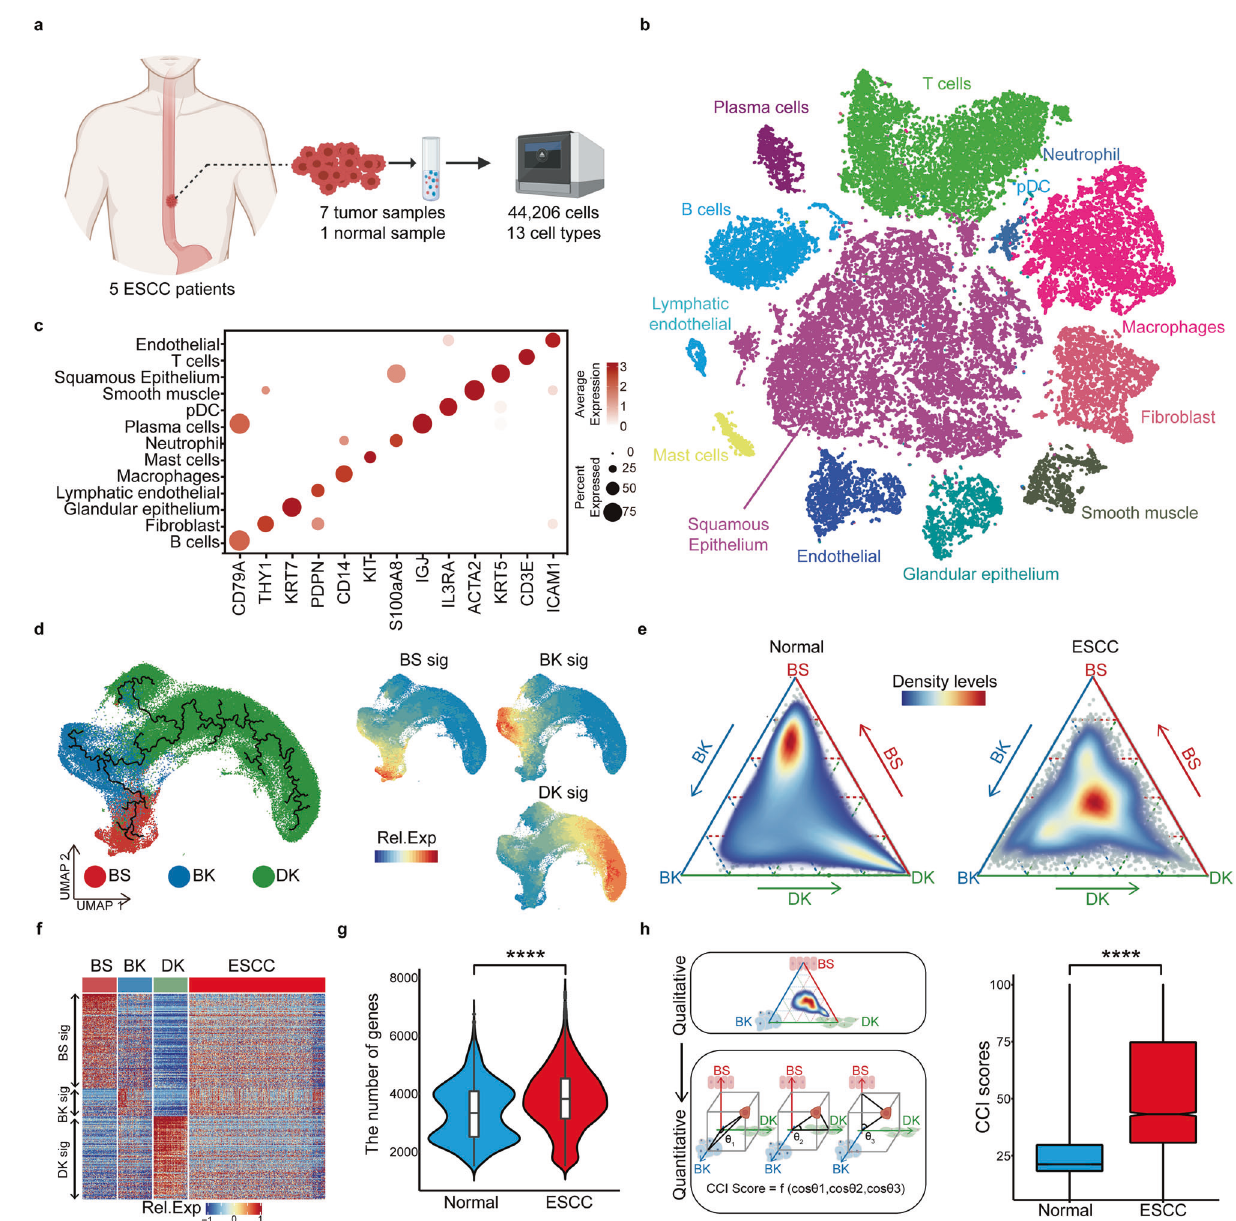
Fig. 1 Confused cell identity (CCI) is a feature of ESCC cells at single-cell resolution. a The schematic graph of the experimental design. b The t-SNE map of single-cell ESCC landscape was colored by cell subtypes. c The dot plot showed the expression levels of classical signatures in each cell subtype. d The UMAP map of normal squamous epithelial (SE) was colored by cell subtypes. The black lines, fi tted by monocle3, represented the development lineage of normal SE (left). The distribution of expression levels of BS, BK, and DK signatures on the UMAP map (right). e The ternary diagram showed the similarity/variation in scRNA-seq data of SE from the normal esophagus (left) and ESCC (right), with BS, BK, and DK cells. The color represented the density levels of distribution. f The heatmap showed the expression levels of BS, BK, and DK signatures in scRNA-seq data. g The boxplot showed the number of genes detected in normal and ESCC SE cells ( n = 4052 cells, normal; n = 7580 cells, ESCC). p Values calculated by two-sided unpaired t -test. **** p < 0.0001. h The schematic graph of CCI scores calculation (left). The box plot showed the CCI scores in single-cell normal samples and ESCC samples (right, n = 4860 cells, normal; n = 6801 cells, ESCC). p Values calculated by Wilcoxon signed-rank test. **** p < 0.0001 Table 1). On the t-SNE map, all these samples were essentially epithelial cells, we optimized the dissociation protocol to harvest evenly distributed (Supplementary Fig. S2b – e). more than a twofold number of epithelial cells than previous All the esophageal squamous epithelial cells expressed high methods (Supplementary Fig. S1c). 30 Total 44,206 cells were levels of marker gene KRT5 (Supplementary Fig. S2a). In patients, obtained, including 16,657 normal and malignant squamous the squamous epithelial cells displayed obvious copy number epithelial cells. The squamous epithelial cells, glandular epithelial variations, compared to other cells, calculated by inferCNV cells, immune cells, endothelial cells, and other tumor micro- (Supplementary Fig. S2f). Thus, these cells were identi fi ed as ESCC environmental cells were separated and identi fi ed with classic cells. In normal esophageal tissues, the esophageal squamous markers (Fig. 1b, c, Supplementary Fig. S2a and Supplementary Signal Transduction and Targeted Therapy (2022)